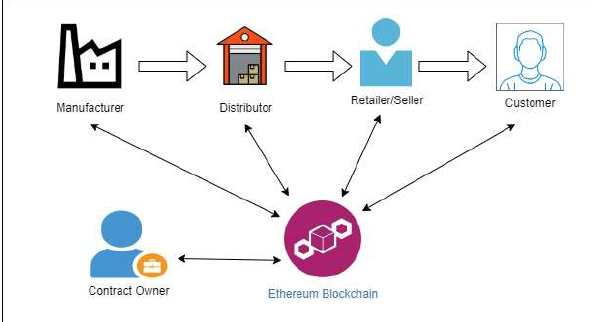
Fig. 1. Different Entities and their interaction with Smart Contracts stored in